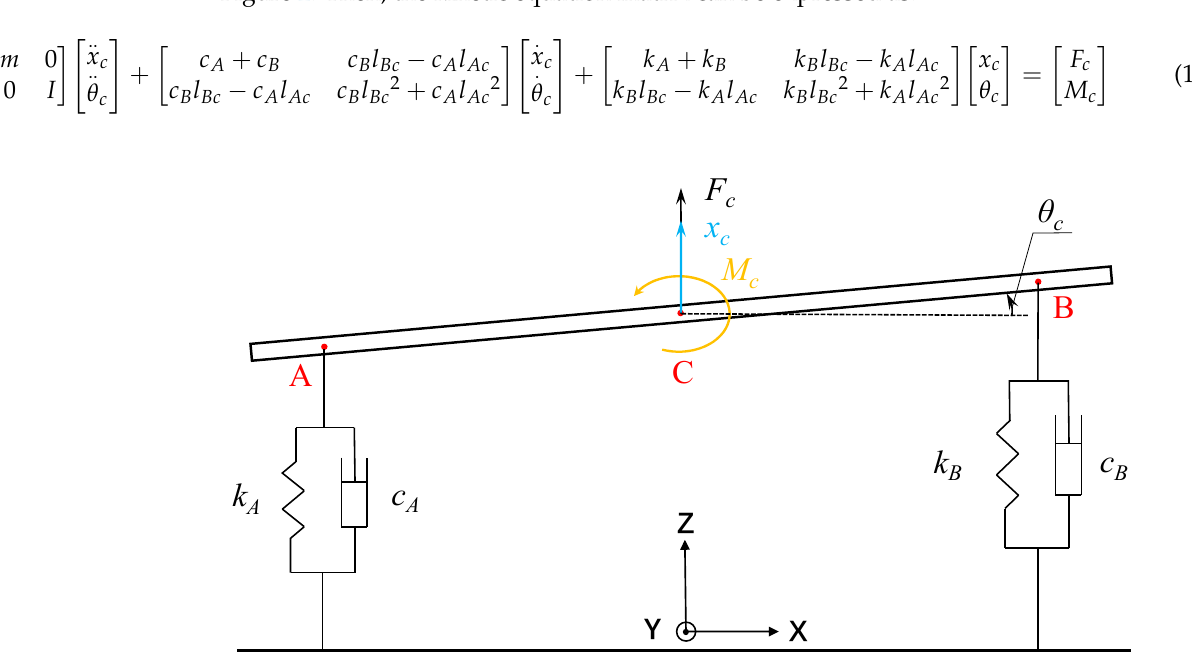
air film, and the bottom VPL porous aerostatic bearing only supports the X -axis slide in Figure 1. The basic arrangement of the X -axis and Y -axis of a three-axis machine tool. the vertical direction. Now, the X -axis slide is considered a rigid body, and the dynamic characteristics of the slide in the vertical direction can be studied. In order to facilitate the analysis and calculation, the vertical dynamic model of the X -axis slide was simplified to a two-degree-of-freedom system composed of rigid rods, springs, and dampers, as shown in Figure 2. Then, the kinetic equation matrix can be expressed as: